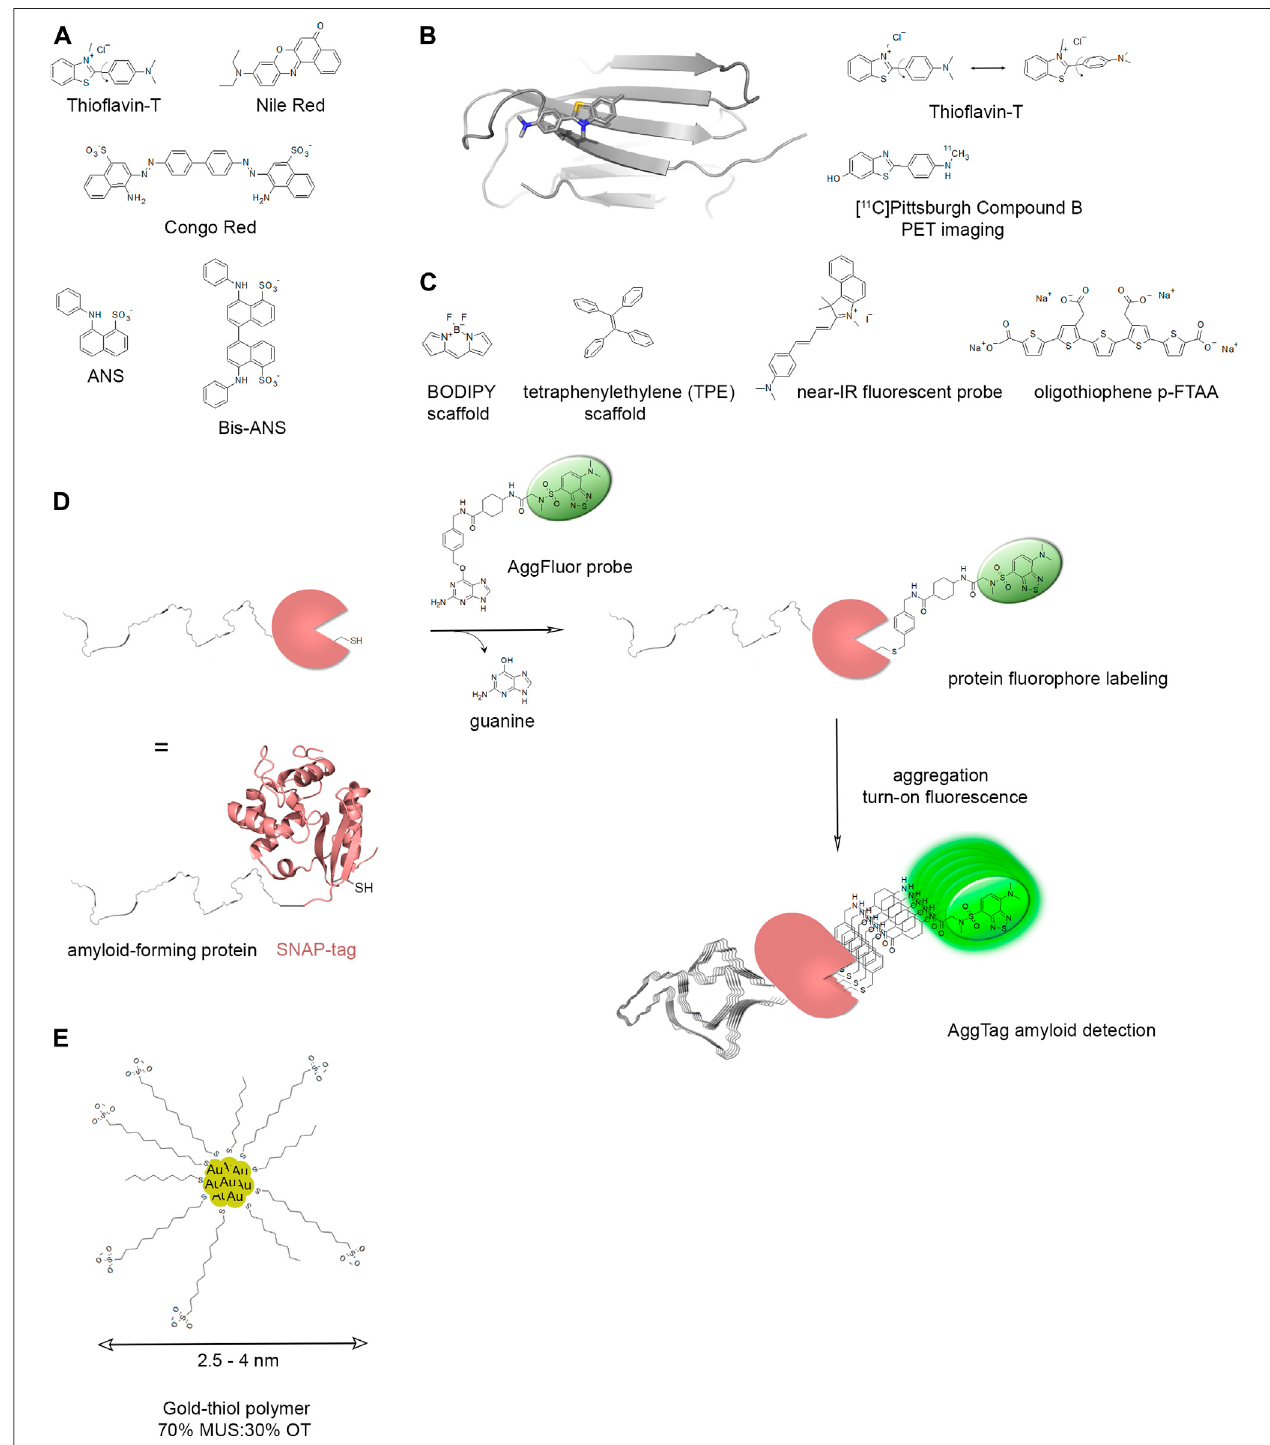
FIGURE 8 | Detection of amyloids by fl uorescence labeling (A – D) or functionalized gold nanoparticles (E) . (A) Structures of extrinsic fl uorescent probes used for amyloid detection. (B) Aggregation-induced emission (AIE) molecules exempli fi ed by Thio fl avin-T (ThT) emit a fl uorescent signal upon binding into hydrophobic pockets of amyloid β -sheet structures due to restriction of intramolecular rotation (PDB ID: 3MYZ). Thestructure of[ 11 C]-Pittsburgh Compound B used for PET imaging isbased on ThT structure. (C) Some examples of fl uorescent molecules based on BODIPY or tetraphenylethylene (TPE) scaffolds are depicted as well as a near-infrared (near-IR) fl uorescentprobeandtheoligothiophenep-FTAA(pentamericformofformylthiopheneaceticacid). (D) Anexampleof fl uorescentSNAP-taggingisdepictedin astrategycalled “ AggTag ”